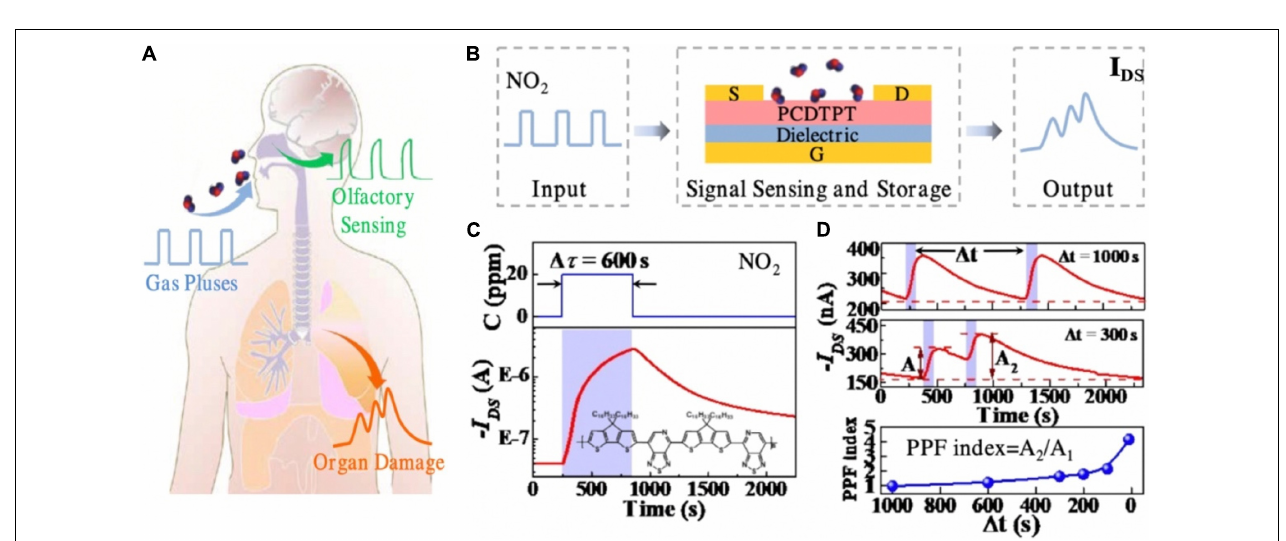
FIGURE 13 | (A) Schematic image that shows different injuries of hazardous gas on human and organs and olfactory. (B) Schematic of the operation concept of the artificial organ-damage device. (C) Typical response/recovery characteristics of the device to 20 ppm NO 2 . (D) Real-time I DS to two successive 20 ppm NO 2